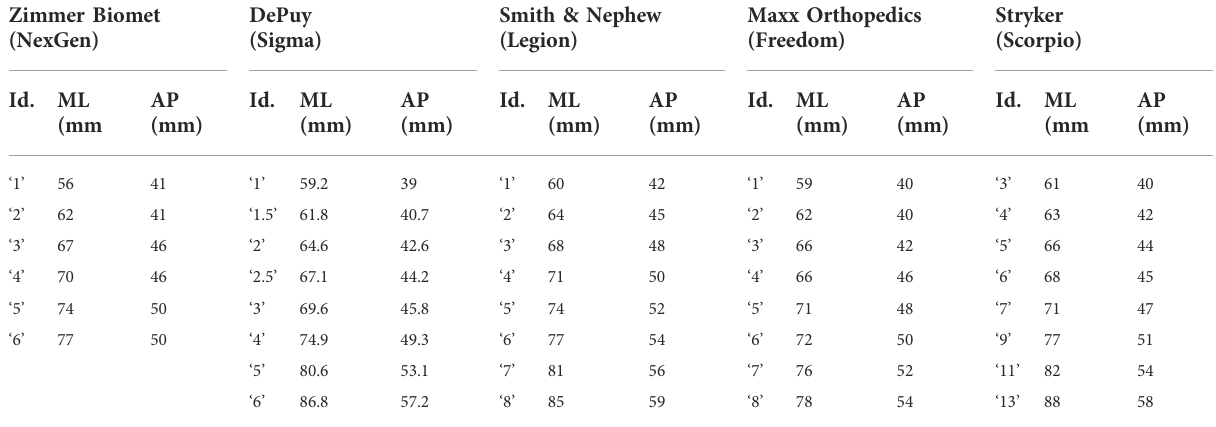
TABLE 3 Tibia plate sizing chart, detailing the manufacturer, model, size identi fi er, and ML/AP dimensions (obtained from respective surgical technique manuals). Zimmer Biomet